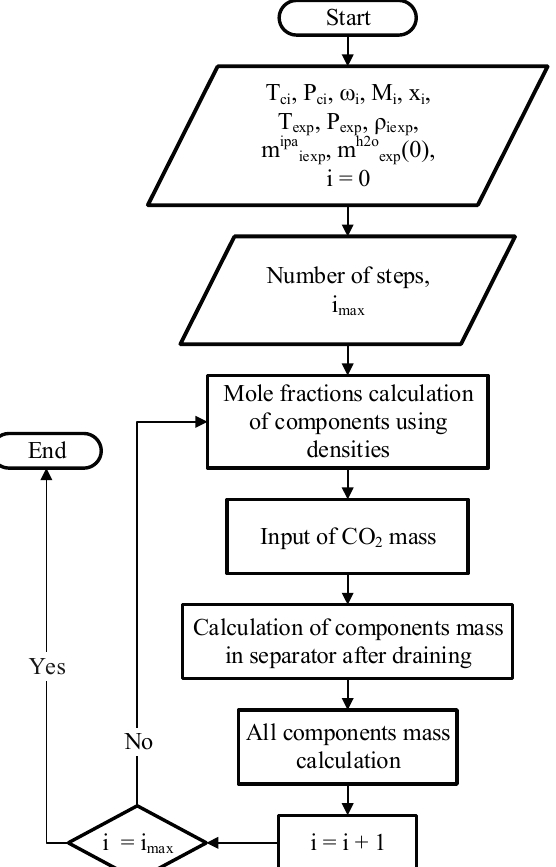
Figure 8. Algorithm for processing experimental data.